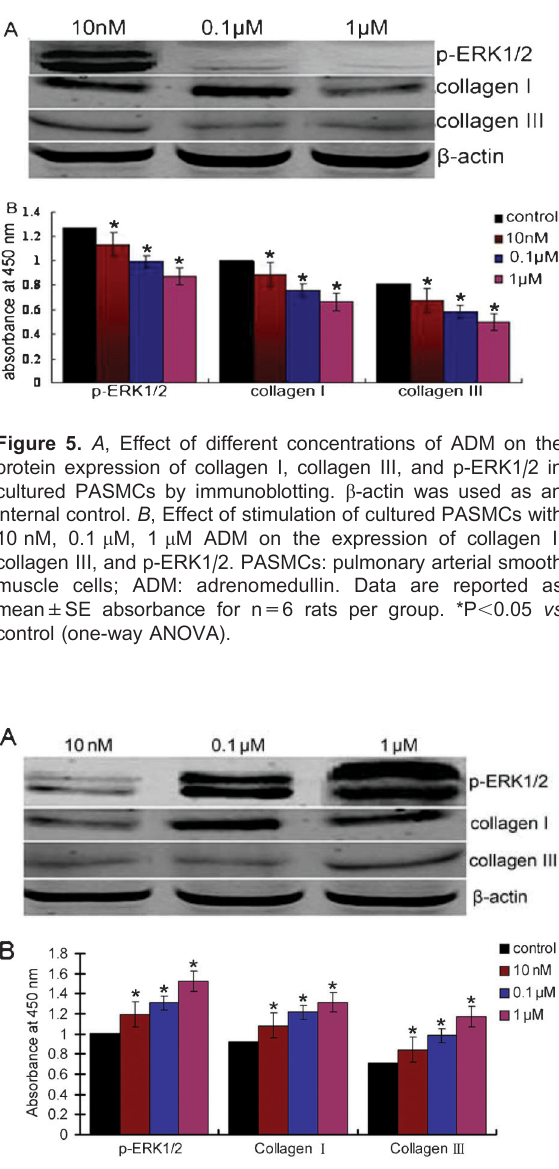
Figure 7. Effect of PD98059 on p-ERK1/2 protein expression of cultured PASMCs stimulated by ( A ) 0.1 m M ADM or ( B ) 0.1 m M ADT, shown by immunoblotting. b -actin served as an internal control. Summary data of the influence of PD98059 on the expression of p-ERK1/2 in cultured PASMCs stimulated by ( C ) 0.1 m M ADM or ( D ) 0.1 m M ADT. PASMCs: pulmonary arterial smooth muscle cells; ADM: adrenomedullin; ADT: adrenotensin. Data are reported as mean±SE absorbance for n=6 rats per group. *P , 0.05 vs control (one-way